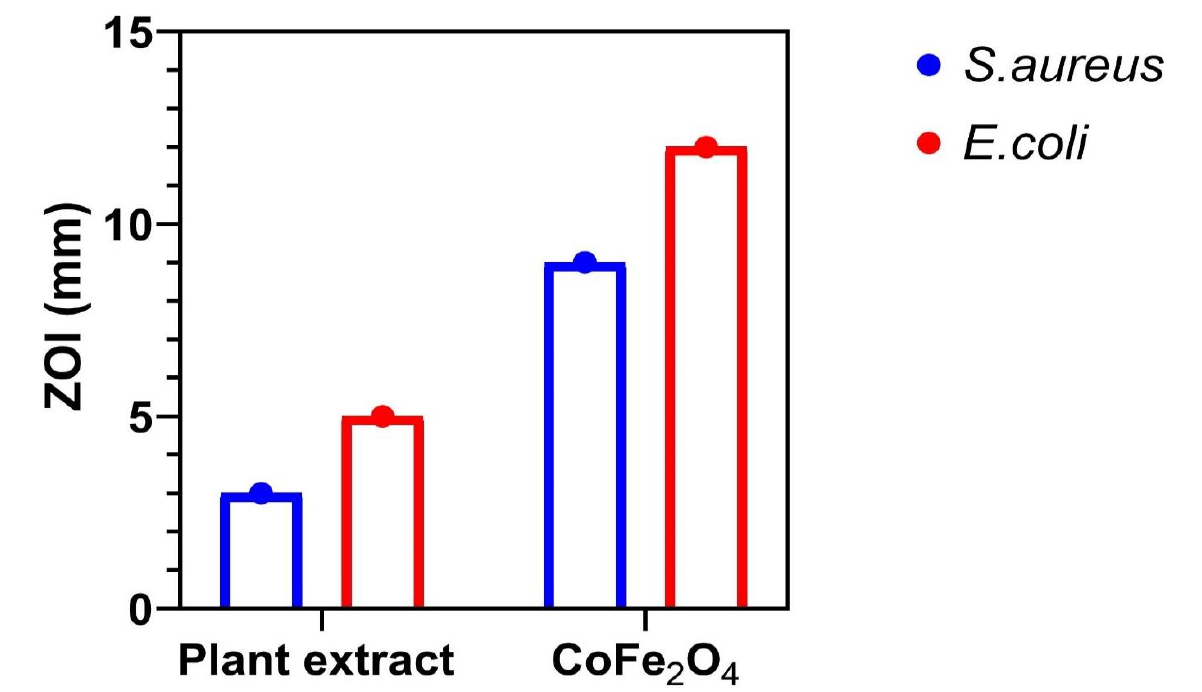
Figure 11. Antibacterial activity of biosynthesized CoFe 2 O 4 nanoparticles.